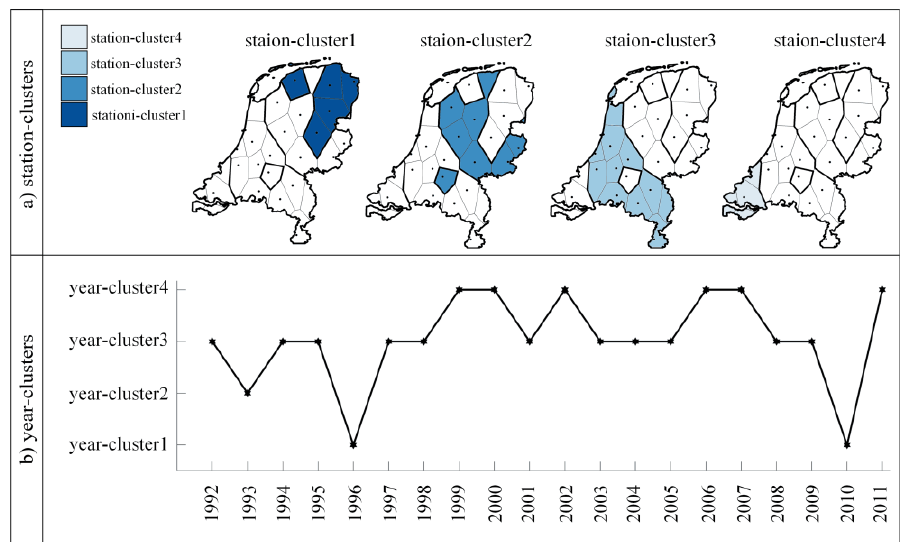
Figure 7. Spatio-temporal clusters (( a ) station-clusters; ( b ) year-clusters) identified in Dutch temperature data at the yearly resolution.